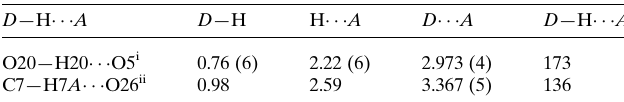
Table 2 Hydrogen-bond geometry (A˚ , (cid:5) ) for (II).